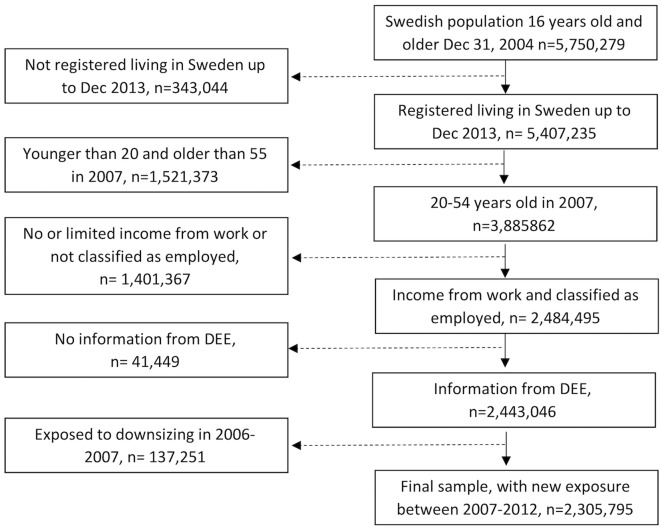
Flow chart of study sample, based on information from the Longitudinal integration database for health insurance and labor market studies (LISA) and Statistics on Dynamics of Enterprises and Establishments (DEE).